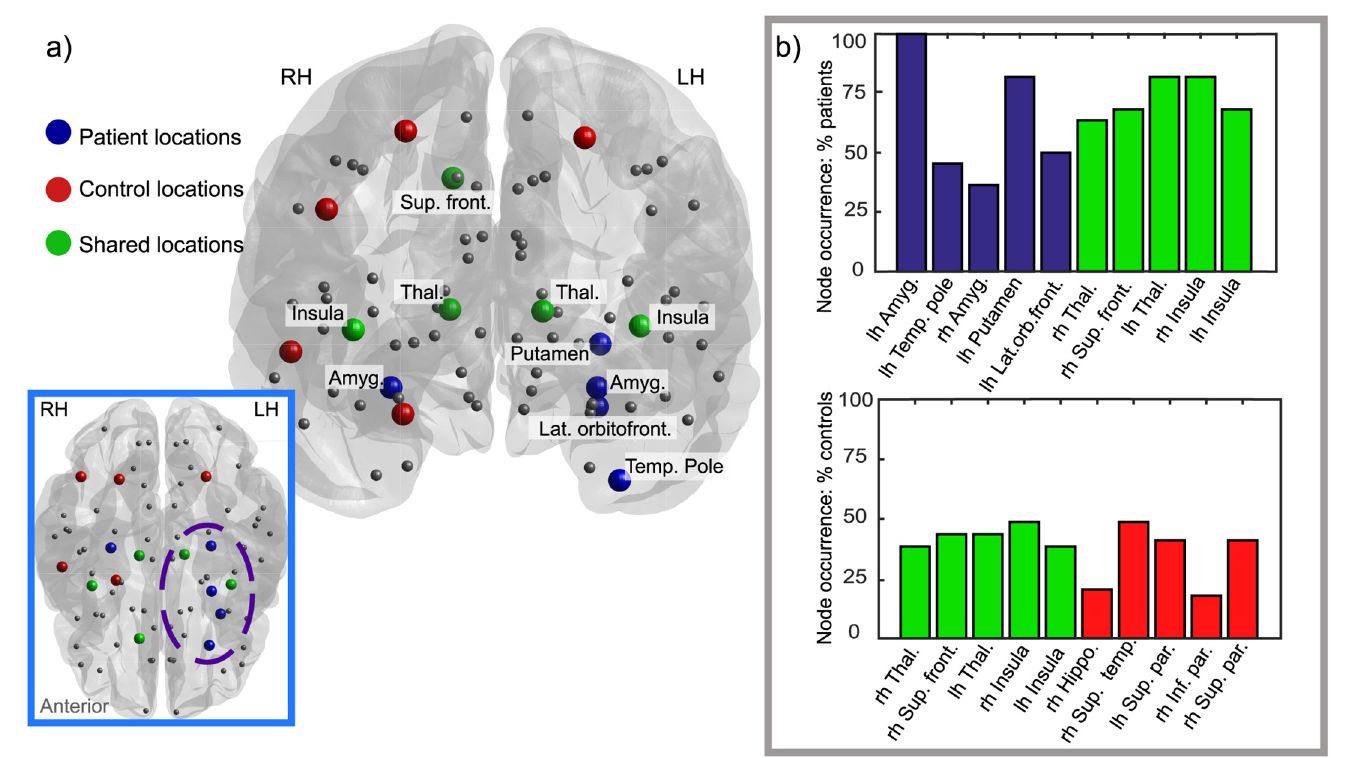
Fig 2. Patient-control ten earliest escape locations compared. Part a) shows the locations of the top ten most ‘ seizure-prone ’ nodes. These were found by taking the mode over the first three nodes to escape for each subject (split into patient and control groups) for all simulations without resections. The nodes represent locations in the brain network, and are coloured according to the group they escaped first in — blue for patients, red for controls and green for where the location was in the top ten to escape for both groups. Smaller grey circles show the locations of other nodes in the network which were not in either top ten. The main figure has location labels for patient areas, and the inset figure (transverse plane) has a dashed line encircling the main group of nodes for patients which are clustered in or around the temporal lobe. It is perhaps worth noting that while escape times are not apparent in this image controls nodes did take longer to escape than patients for all locations. Part b) shows the consistency of the top ten nodes compared for patients and controls, where patients show greater consistency for all the shared nodes and strikingly the left hemisphere amygdala escaped to the seizure state in every single patient at least once over 100